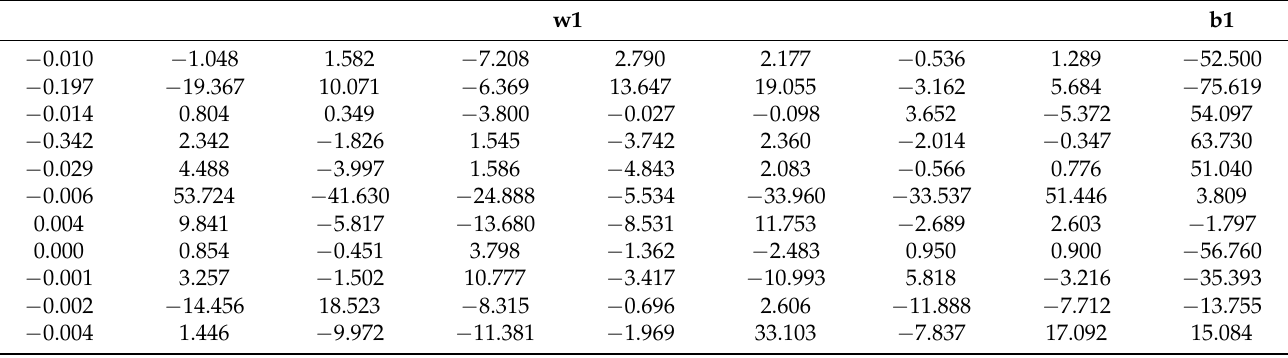
Table 5. The weights and bias from the input layer to the hidden layer.